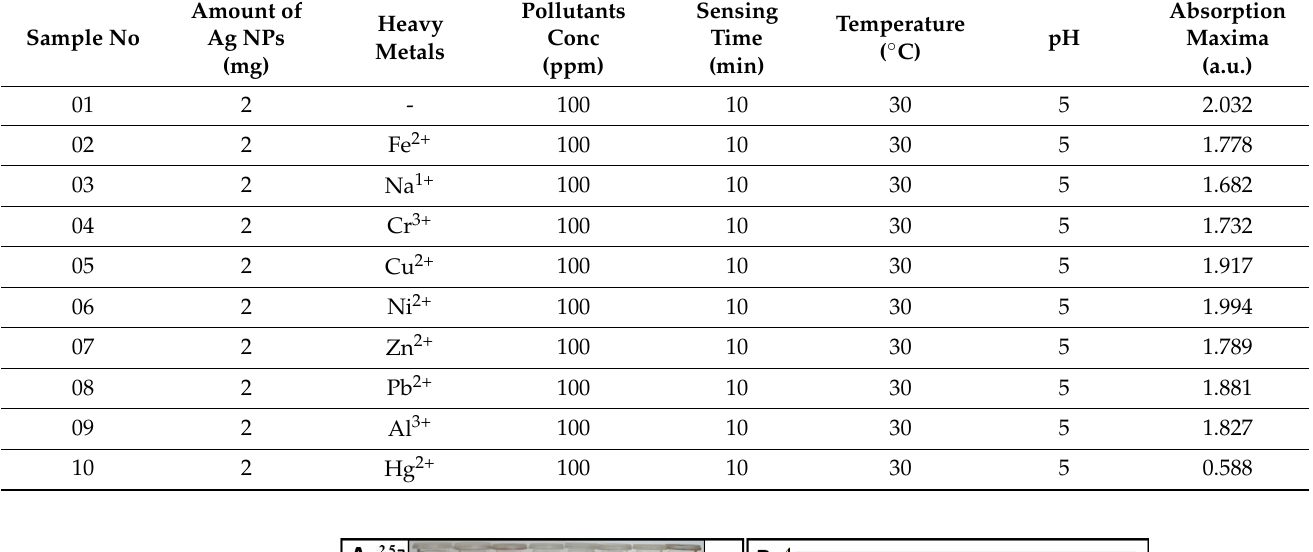
Table 3. Experimental details for the screening of different heavy metals by AgNPs.